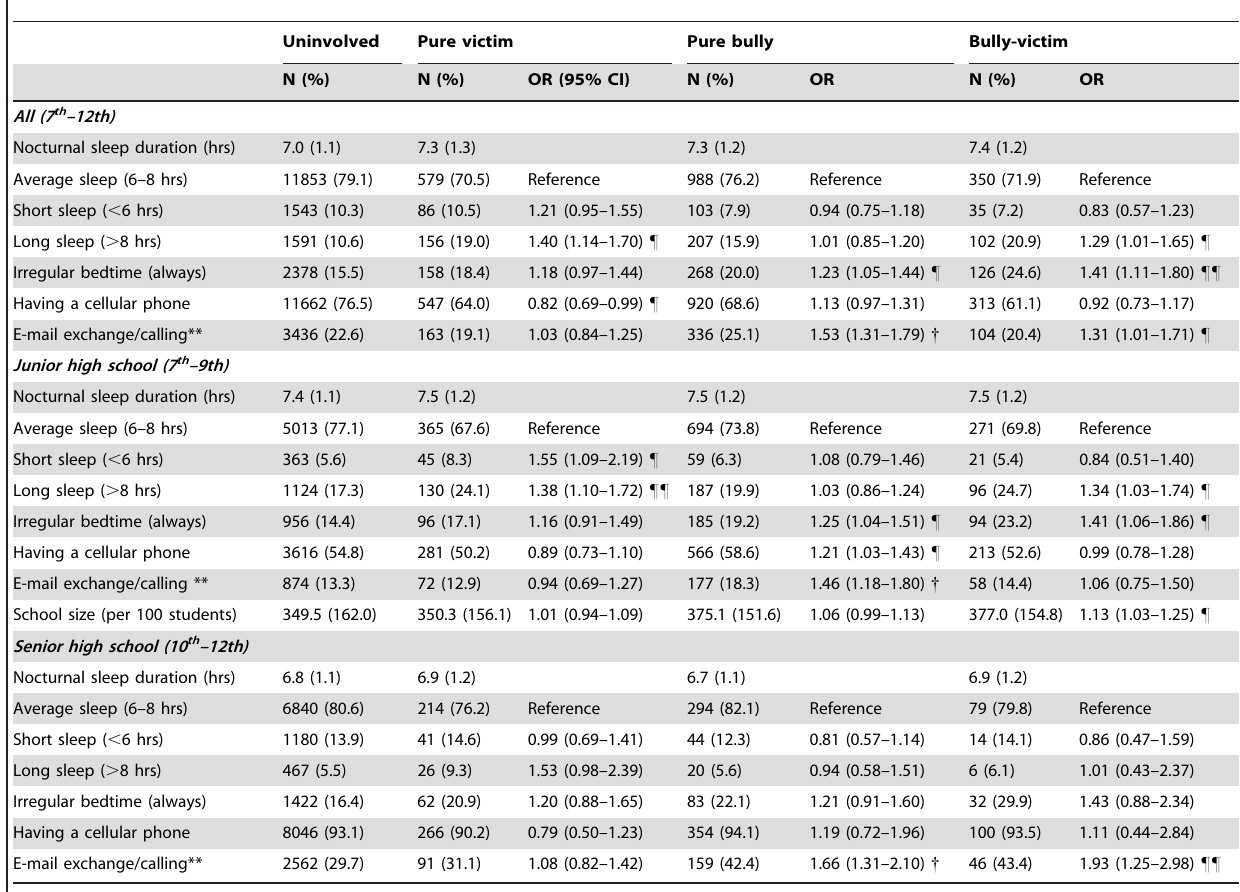
Table 2. Relationship between sleep pattern, nocturnal cellular phone usage and the bullying